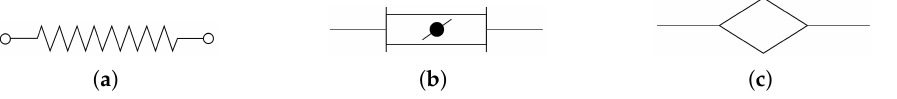
Figure 6. Model component. ( a ) Spring element. ( b ) Damper element. ( c ) Fractional-damper element.